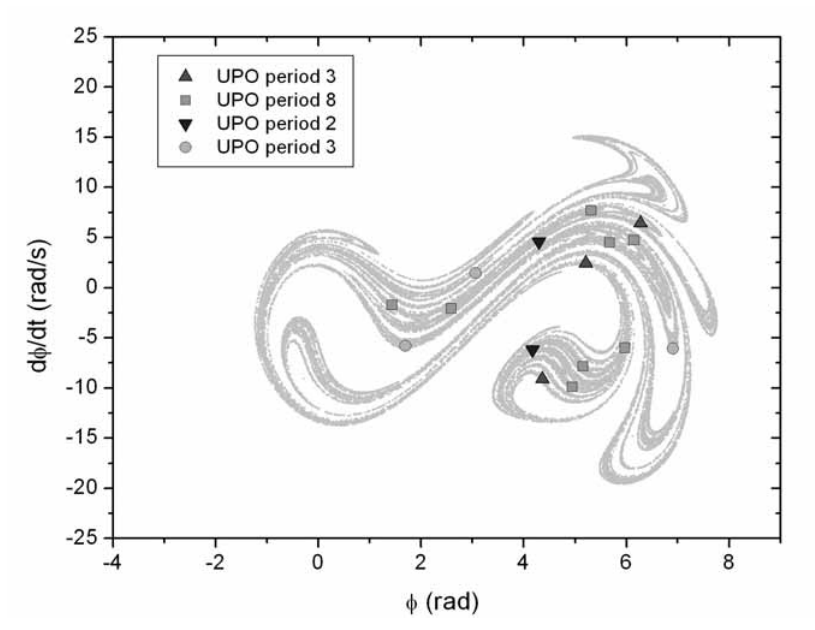
Fig. 2. Strange attractor in intermediate sections showing identified UPOs.